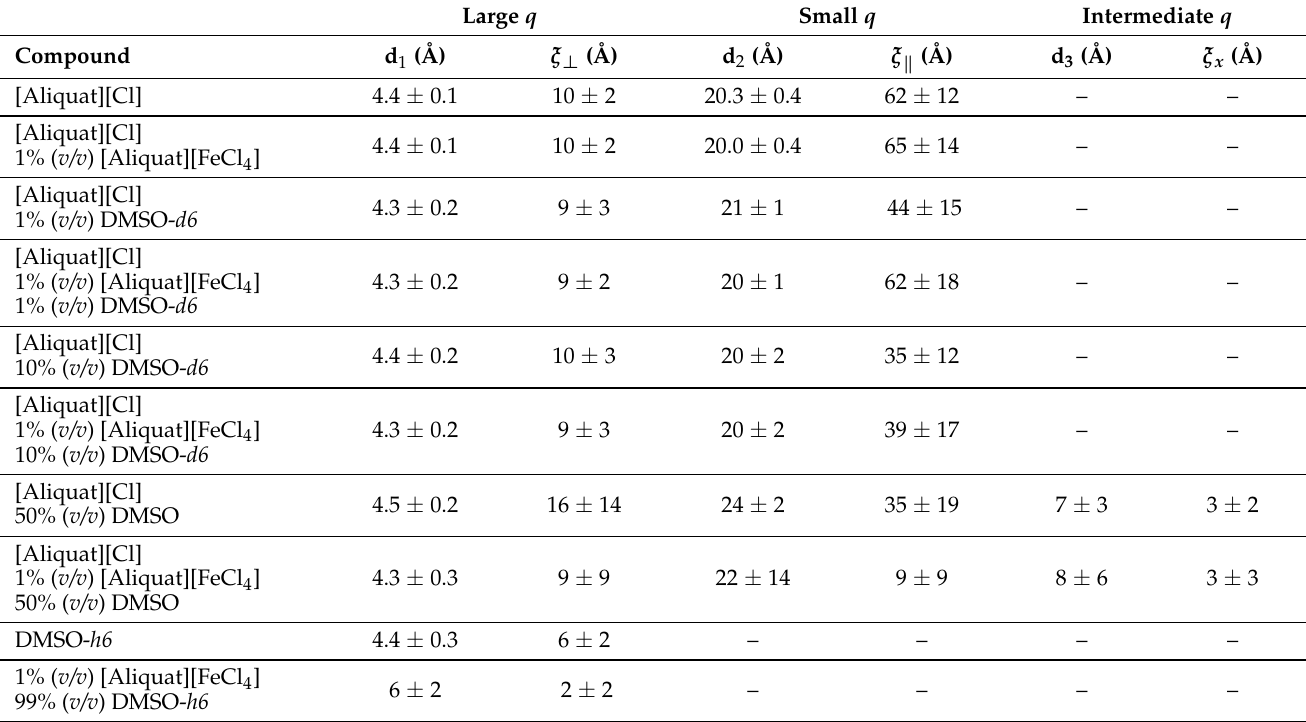
Table 2. Parameters obtained from the X-ray diffractometry experiments performed at 25 ◦ C. The characteristic distances d i were obtained using Bragg’s law, and the aggregate sizes ξ i were calculated using Scherrer’s equation. The uncertainties were estimated using the model fitting χ 2 as an estimator of the